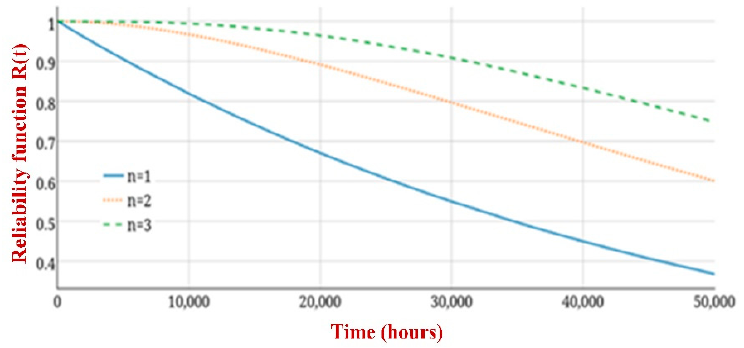
Figure 22. The impact of series redundancy on NPC dependability.